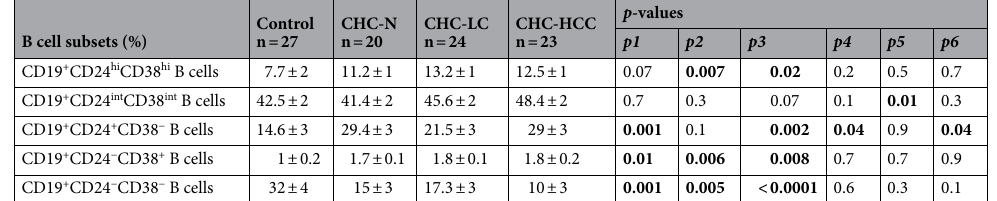
Table 3. CD19 + B cell subsets in chronic hepatitis C patients with respect to the degree of liver affection. (%) the percentage was calculated from CD19 + B cells. CHC-N chronic hepatitis C with no cirrhosis or hepatocellular carcinoma, CHC-LC chronic hepatitis C with liver cirrhosis, CHC-HCC chronic hepatitis C with hepatocellular carcinoma. Results expressed as mean ± standard error. Multivariate analysis of covariance (MANCOVA) with age and sex as covariates Significant p- value is < 0.05 (bold). p 1: CHC-N vs. Control p 2: CHC-LC vs. Control p 3: CHC-HCC vs. Control. p 4: CHC-N vs. CHC-LC p 5: CHC-N vs. CHC-HCC p 6: CHC-LC vs.